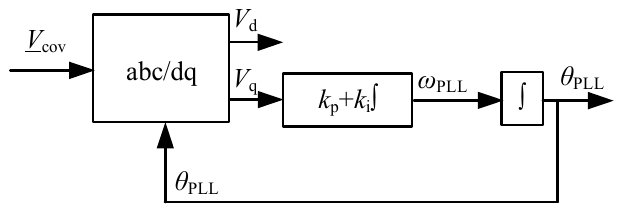
Figure 2. Block diagram of an SRF PLL.